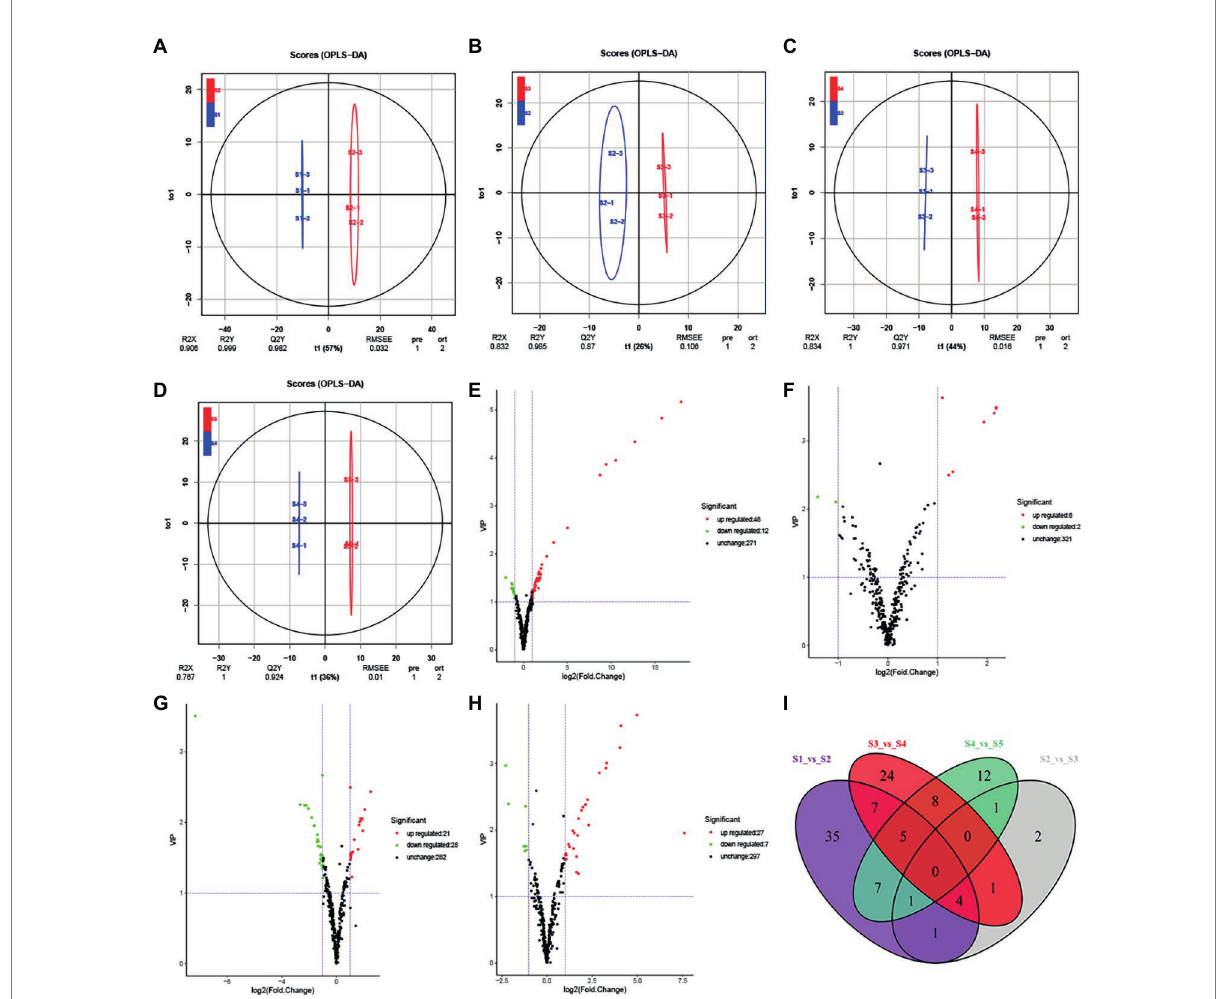
FIGURE 2 Differential secondary metabolite analysis of the samples in five developmental stages of the S. japonica flower. (A − D) Orthogonal partial least squares discriminant analysis (OPLS-DA) model plots for the following comparisons: S1 vs. S2, S2 vs. S3, S3 vs. S4, and S4 vs. S5, respectively. (E − H) Volcano plots showing the expression levels of the differential secondary metabolites in the comparisons S1 vs. S2, S2 vs. S3, S3 vs. S4, and S4 vs. S5, respectively. Red dots indicate upregulated, differentially expressed metabolites; green dots indicate downregulated, differentially expressed metabolites; and black dots indicate detected metabolites with insignificant differences in expression. (I) The Venn diagram indicates the common and unique metabolites in the comparison